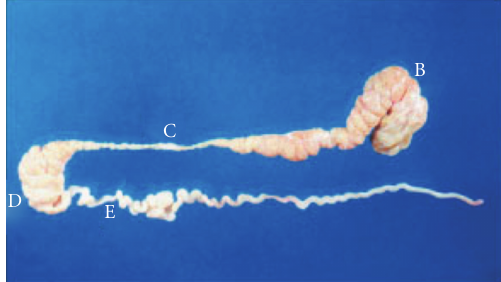
Figure 1: Photography taken from a bull epididymis. Di ff erent anatomical sections are identified: caput (b), corpus (c), and cauda (d). Vas deferens is also indicated (e). Reproduced from [16] with permission of the